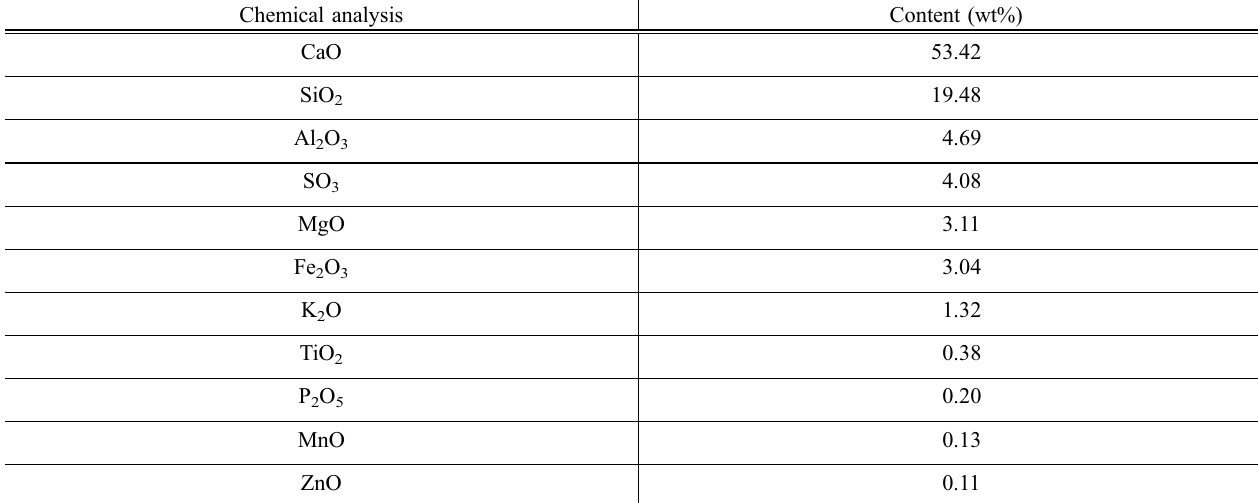
Table 1 Chemical composition of portland cement. Chemical analysis